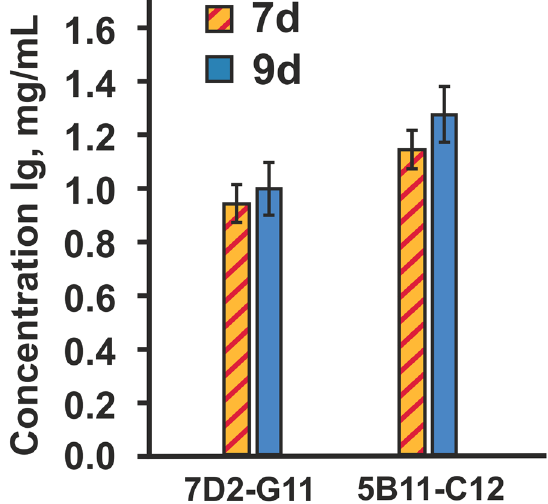
Fig. 5 Comparison of the static shake cultures of selected stable cell lines on 7–9 days. IgG productivity was determined by